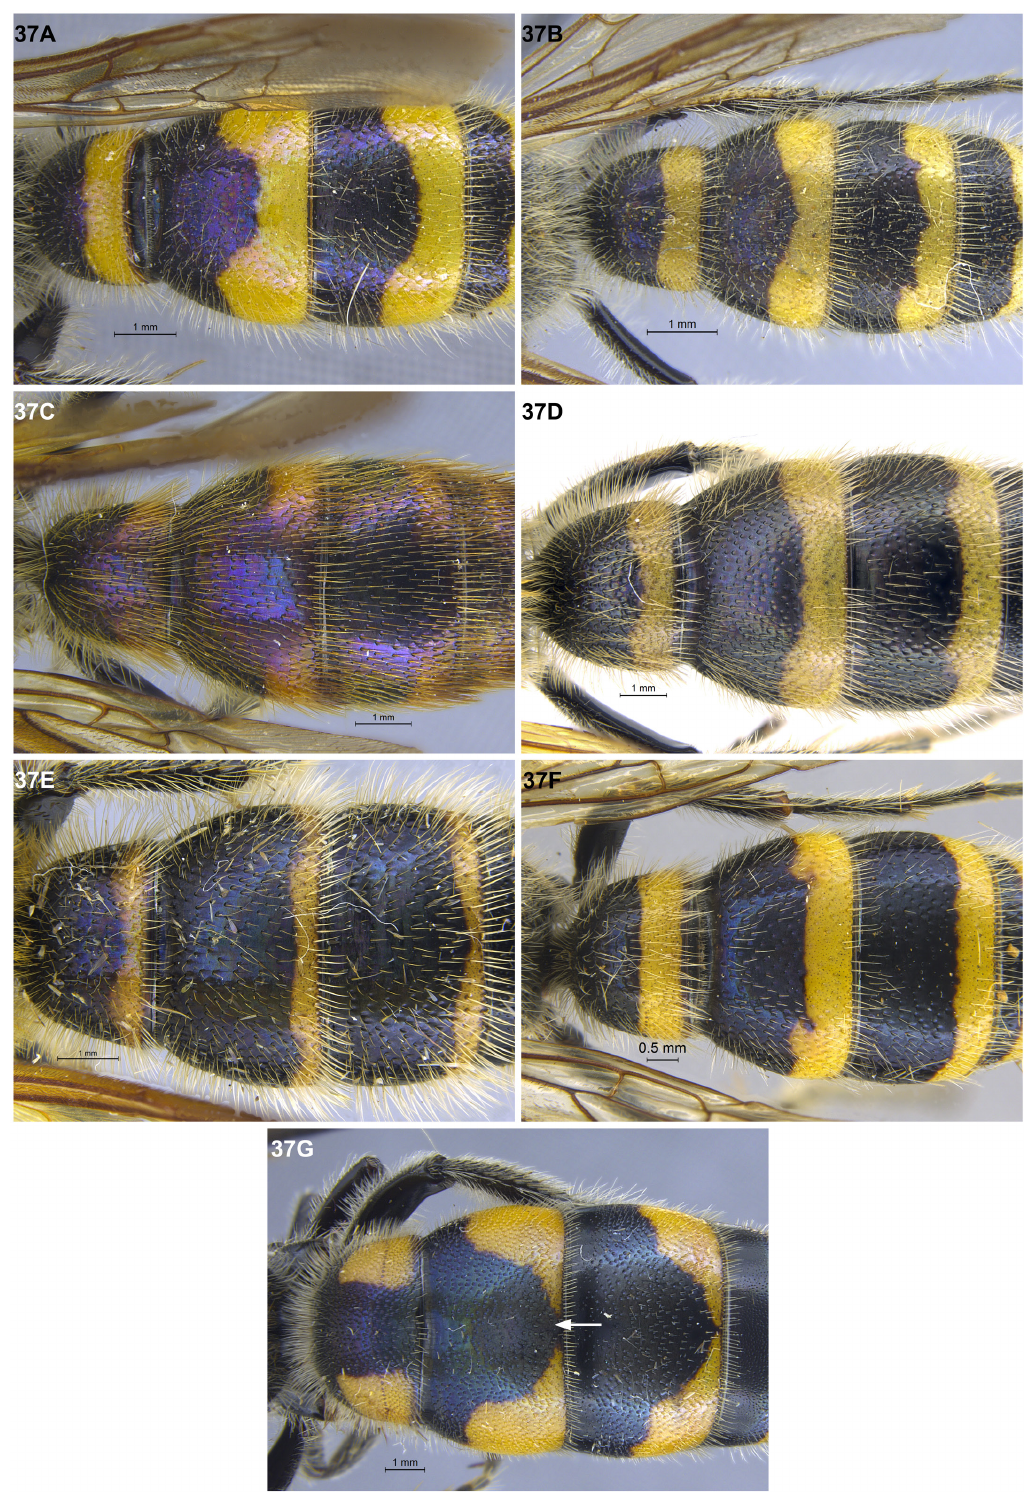
Fig. 37. Males, T1–T3, dorsal view. A . Campsomeriella annulata annulata (Fabricius, 1793). B . Camps. collaris (Fabricius, 1775). C . Megacampsomeris sp. 1. D . Megacam. formosensis chinensis Betrem, 1941. E . Megacam. prismatica (Smith, 1855). F . Phalerimeris phalerata phalerata (de Saussure, 1858). G . Sericocampsomeris flavomaculata Gupta & Jonathan,